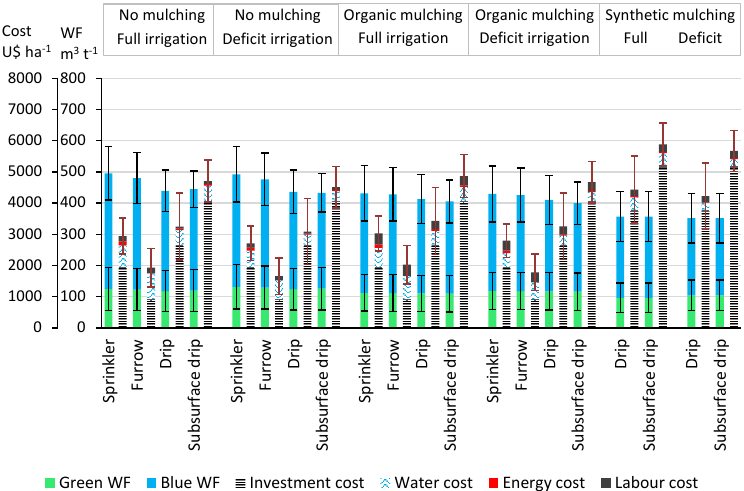
Figure 4. Average WF per product unit (m 3 t − 1 ) for maize production and average annual costs associated with 20 management packages. The whiskers around the WF estimates indicate the range of outcomes for the different cases (different environments, hydrologic years and soil types). The whiskers around cost estimates indicate uncertainties in the